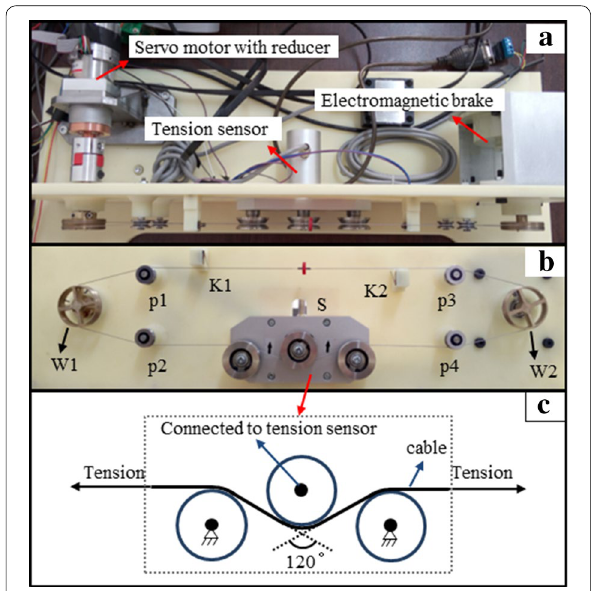
Figure 4 Experimental device: ( a ) top view; ( b ) front view; ( c ) Testing method for cable